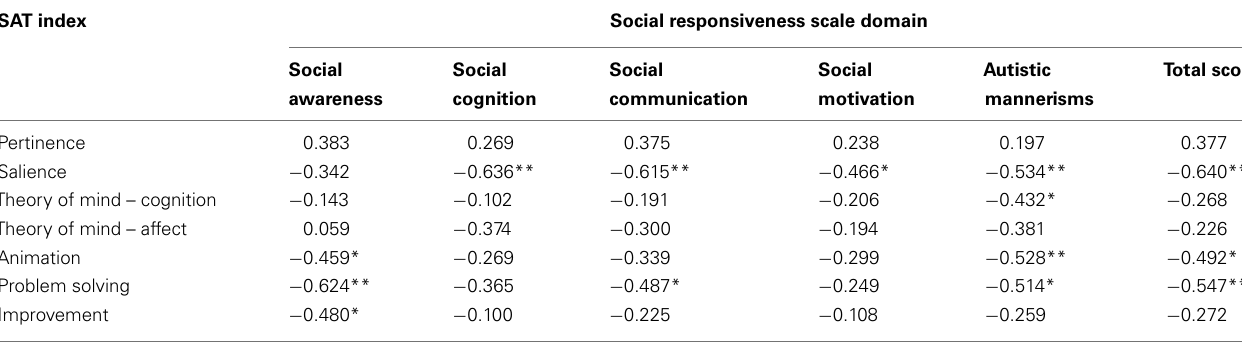
Table 5 | Correlations between SAT performance and parent-reported social reciprocity